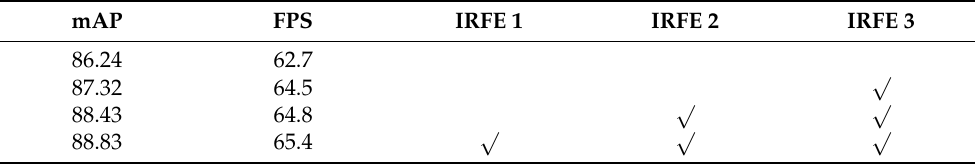
Table 14. The influence of ‘IRFE’ modules on RSOD